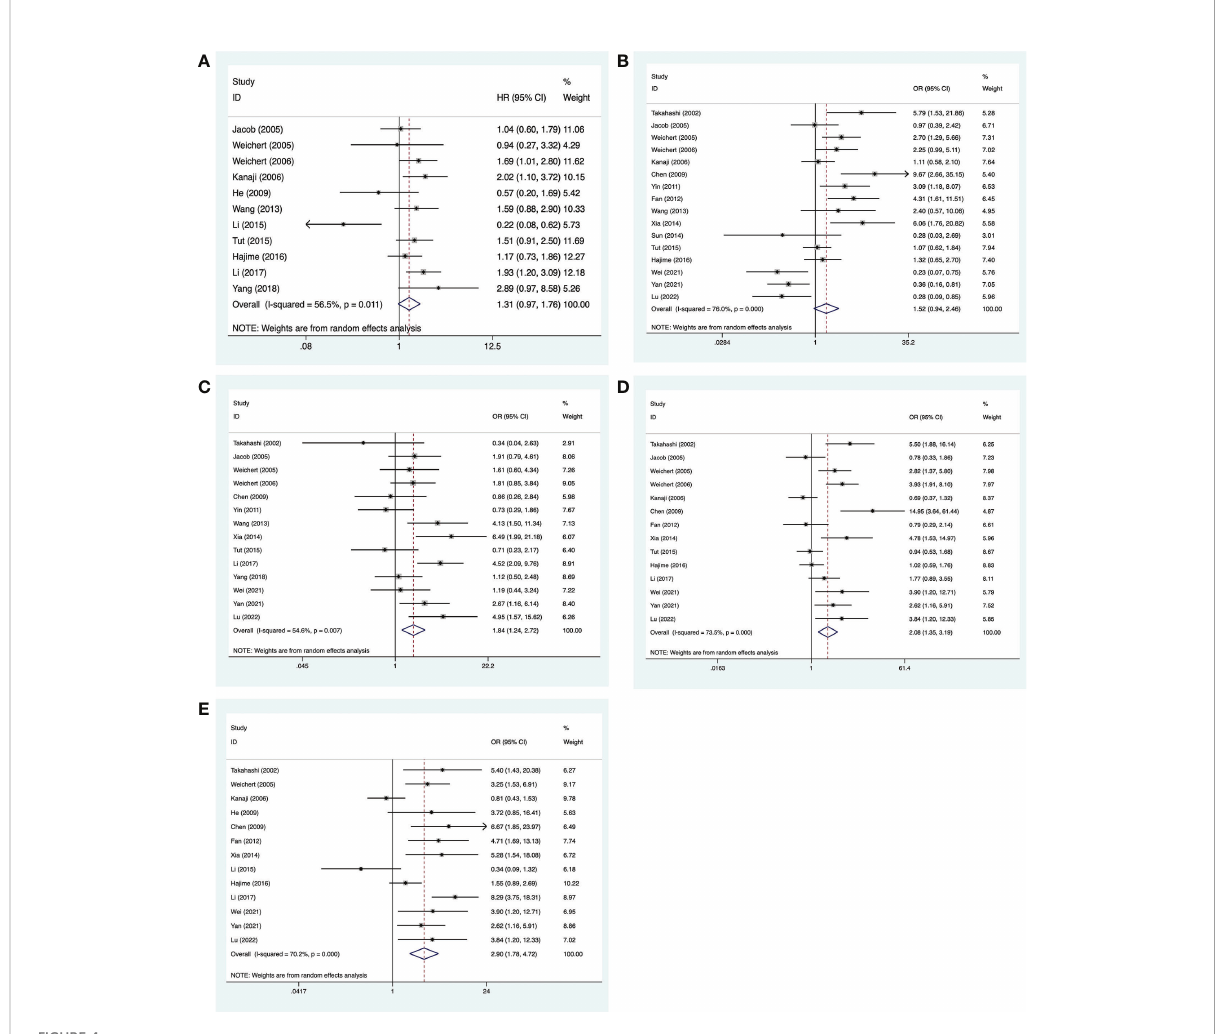
FIGURE 4 Meta-analysis for the association between PLK-1 expression levels and clinicopathological parameters in cancers of the digestive system. (A) 5- year survival; (B) lymph node metastasis; (C) histological grade; (D) primary tumor grade; (E) clinical